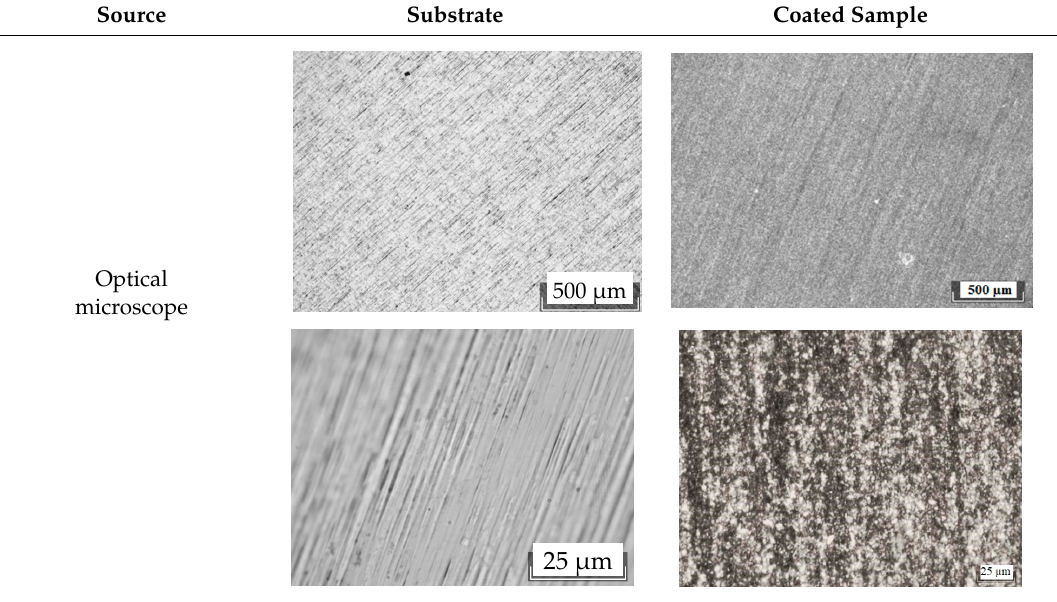
Table 2. Micrographs of a flat molybdenum plate before and after the electrochemical synthesis of the Mo 2 C coating obtained on optical and atomic force microscopes.